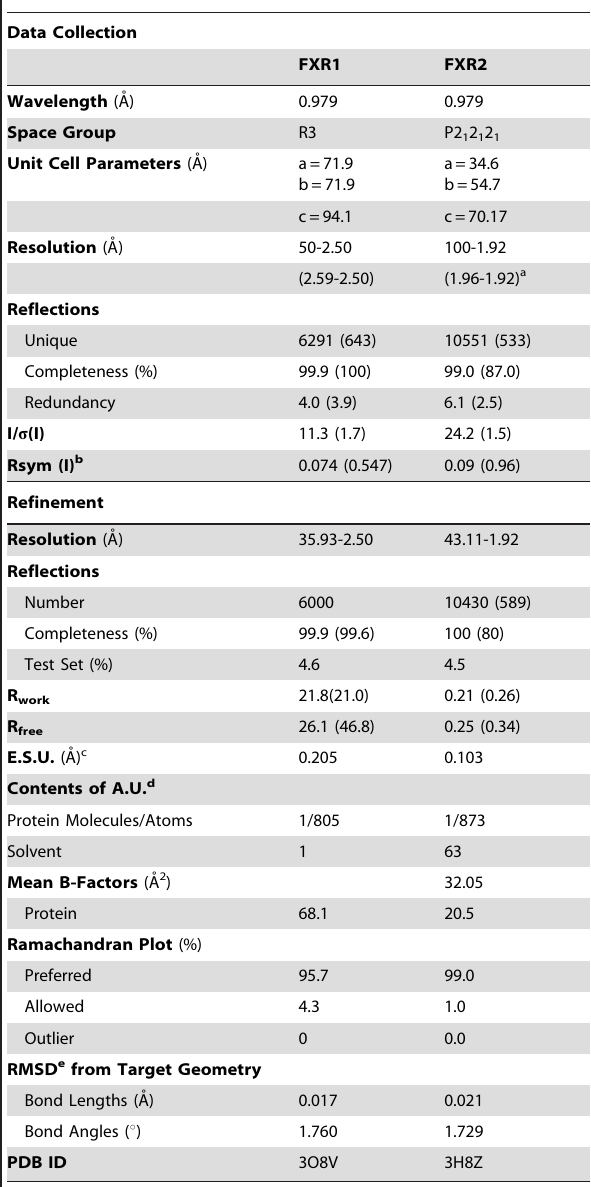
Table 1. Crystallographic and refinement